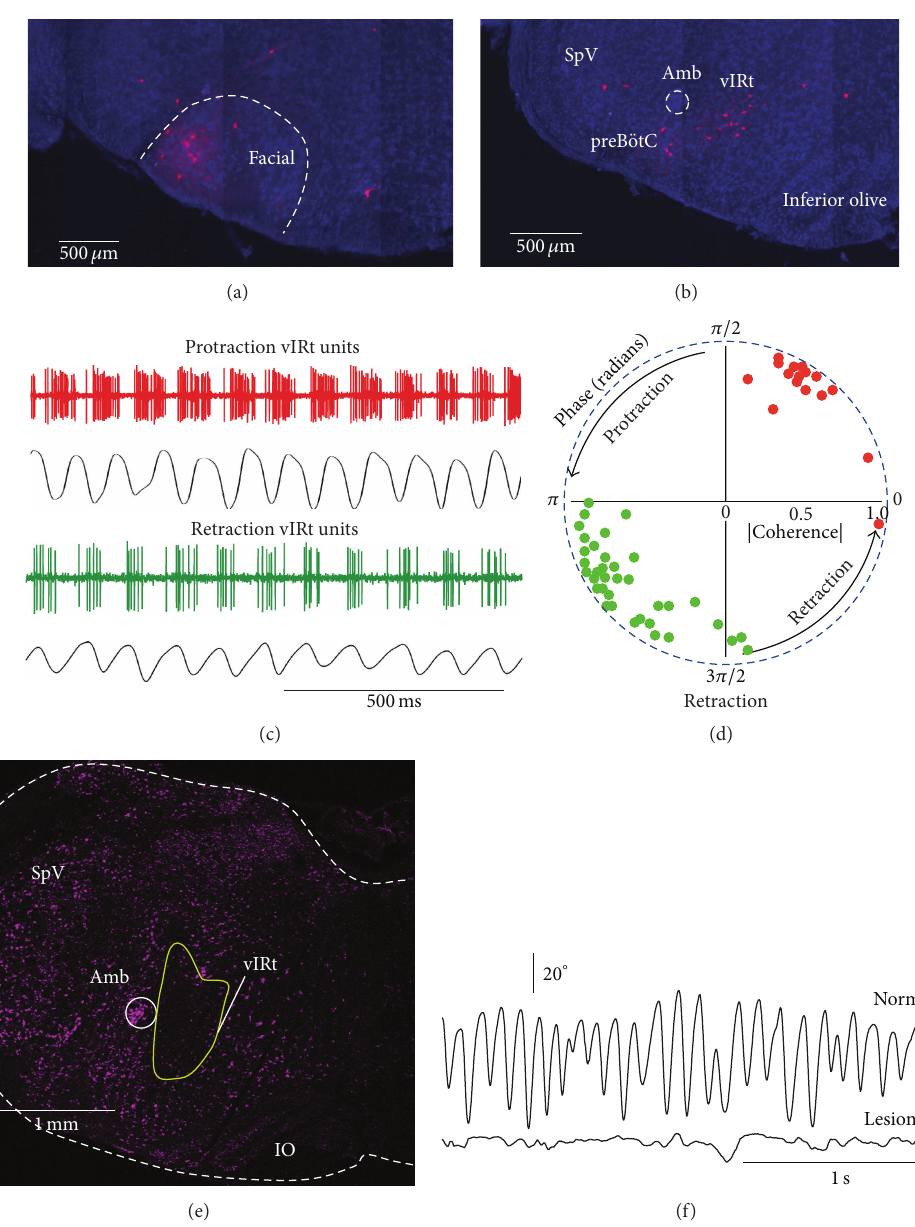
Figure 4: Facial motoneurons and whisking. (a) Δ G-rabies injection into the mystacial pad in mice label motoneurons in the ventral lateral part of the facial nucleus, and premotor neurons (b) in the intermediate reticular formation of the medulla (vIRt). (c) vIRt cells discharge in a phase-locked manner with vibrissa motion during whisking induced by kainic acid injection in the medulla. (d) Polar plot of the coherence between spiking activity of vIRt cells and vibrissa motion at the peak frequency of whisking. Red and green dots represent protraction units and retraction units, respectively. Over 200 whisks per cell were used to compute phase angle and coherence. (e) Ibotenic acid lesion of vIRt leads to abolition of whisking on the side of the lesion (f). All panels are adapted from